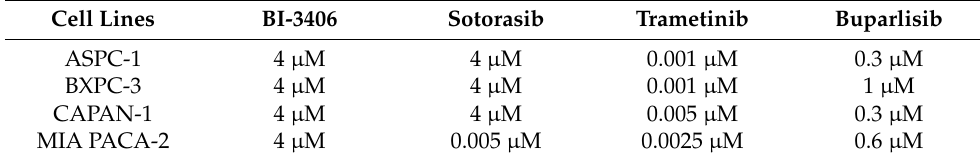
Table 1. Inhibitor concentrations used for combined application. Cell